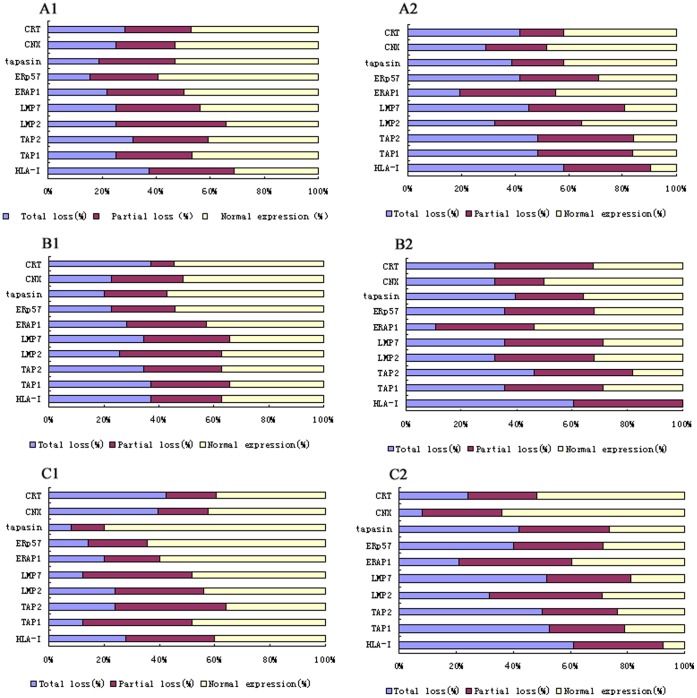
Down-regulation of HLA-I and APM components during the malignant process of cervical cancer.Analyze the clinicopathologic characteristics (tumor grad, clinical stage and Lymph node metastases) with protein expression of HLA-I and APM components (TAP-1, TAP-2, LMP2, LMP7, Tapasin, ERAP1, CNX, CRT and ERp57) in cervical cancer.Results are represented as percentage (%). upper histogram A1 show HLA-I and APM components expressed in well differentiated tumor, A2 show expressed in Moderate to poorly differentiated tumor. B1 show expressed in ≤II a tumor and B2 show expressed in ≥II B, C1 show expressed in Lymph node metastases negative tumor and C2 show expressed in Lymph node metastases positive tumor, respectively. * P < 0.05.